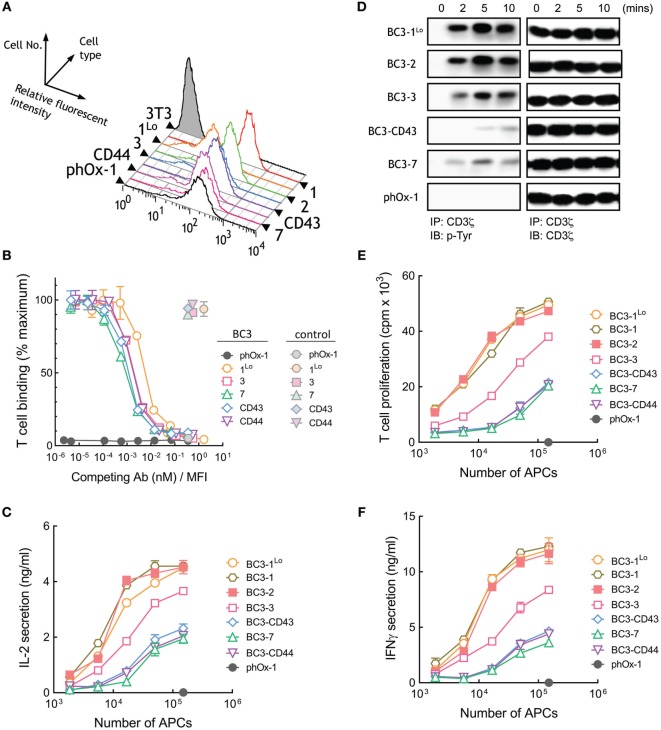
T cell activation by membrane-tethered BC3 scFv depends weakly on tether dimensions. (A) Surface expression of membrane-tethered BC3 scFv on 3T3 cells was measured by FACS. BC3-1Lo cells express low levels of BC3 scFv via the BGP tether (one Ig-like domain). (B) Calcein-AM-labeled Jurkat T cells were incubated with monolayers of 3T3 cells expressing membrane-tethered BC3 scFv in the presence of serial dilutions of BC3 IgG (dark symbols) or 10 µg/ml negative control IgG (light symbols). Unbound T cells were washed away and cellular fluorescence of the remaining bound cells was measured (n = 3). The y-axis shows the mean fluorescence of bound T cells, whereas the x-axis represents the concentration of soluble BC3 IgG added normalized for the level of each membrane-tethered BC3 scFv, as determined by mean immunofluorescence intensity of the 3T3 antigen-presenting cells (APCs) stained with anti-HA antibody. Bars, SD. (C) 5 × 104 Jurkat T cells were incubated with the indicated numbers of BC3 APCs or control phOx-1 APCs for 24 h before the concentration of IL-2 in the culture medium was determined (n = 3). Bars, SD. (D) 107 Jurkat T cells were incubated with 106 of BC3 APCs or control phox-1 APCs for the indicated times before cells were lysed and CD3ζ was immunoprecipitated. Total CD3ζ (right panel) or phosphorylated CD3ζ (left panel) levels were determined by immunoblotting with anti-CD3ζ or anti-phosphotyrosine antibodies, respectively. 5 × 104 human T cells were incubated with BC3 APCs for 24 h before T cell proliferation (E) or IFN-γ in the culture medium (F) was determined (n = 3). Bars, SD.